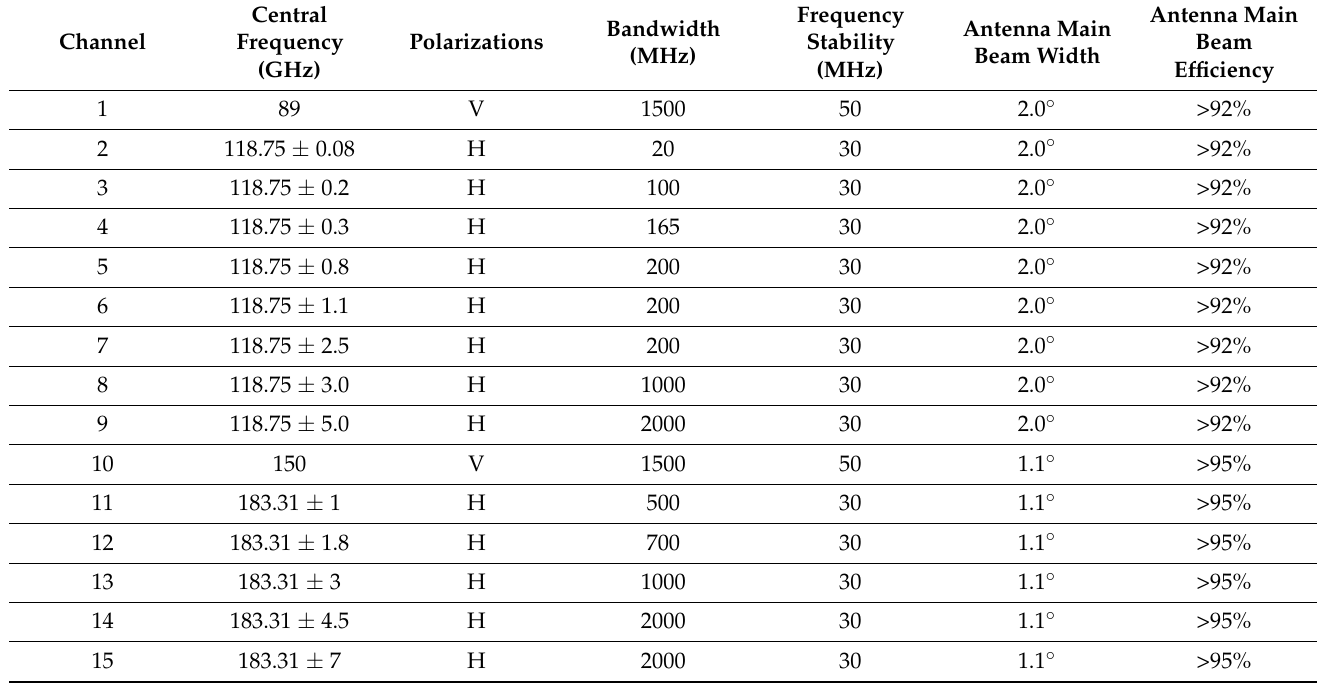
Table 1. FY-3D MWHS-2 sounder